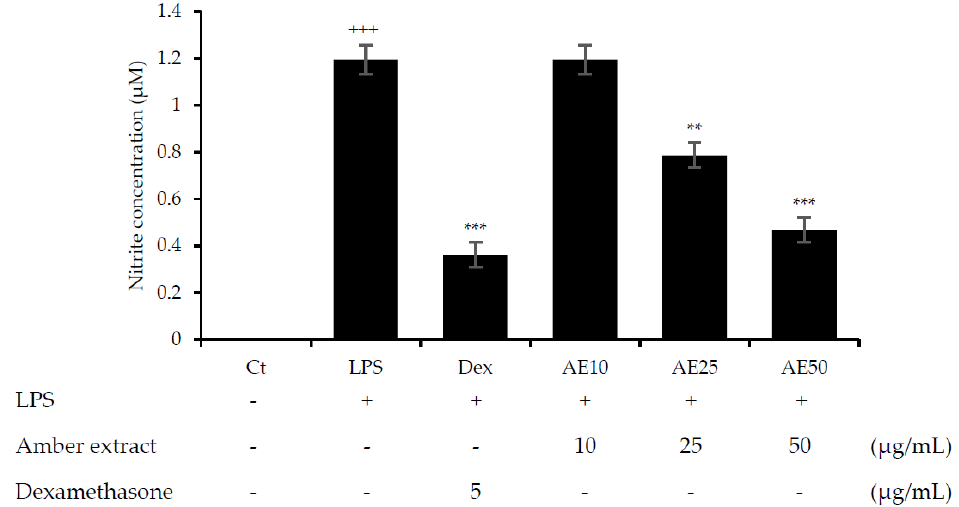
Figure 2. Effect of amber extract on NO production. After culturing the cells with LPS, dexamethasone (DEX), or amber extract (10, 25, and 50 μ g/mL) for 24 h, NO production was measured using the Griess reagent. Data are expressed as mean ± standard error of the mean (SEM) (+++ p < 0.001 vs. control; ** p < 0.01, *** p < 0.001 vs. LPS).